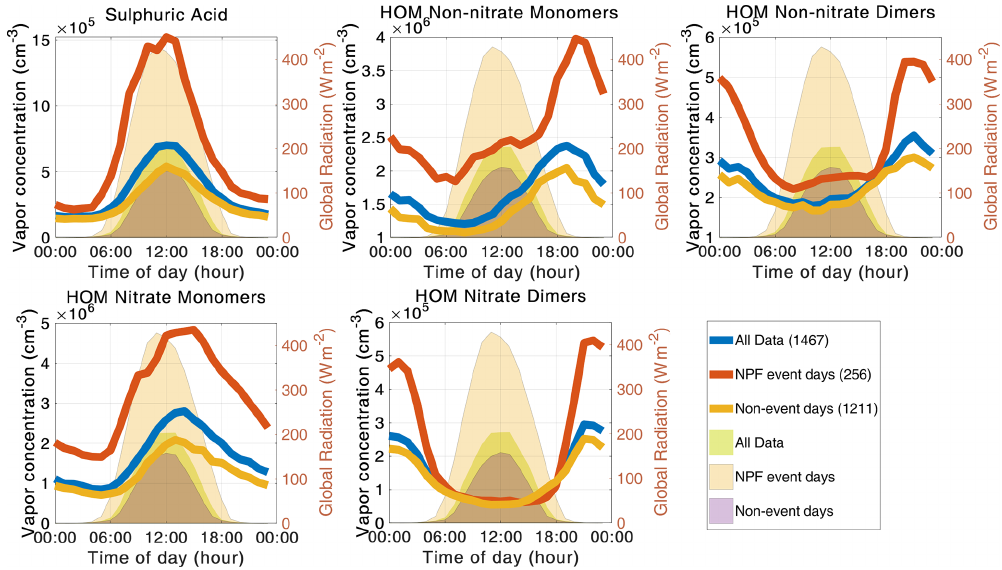
Figure 10. The diurnal cycle for each selected atmospheric precursor vapor for the entire data set (blue), for new particle formation event days (red), and for non-event days (orange). The number of days included in the median day is presented by the number in parentheses in the legend. The light green, light red, and lilac shading are the diurnal cycles of global radiation for all data, NPF event days, and non-event days, respectively (right y